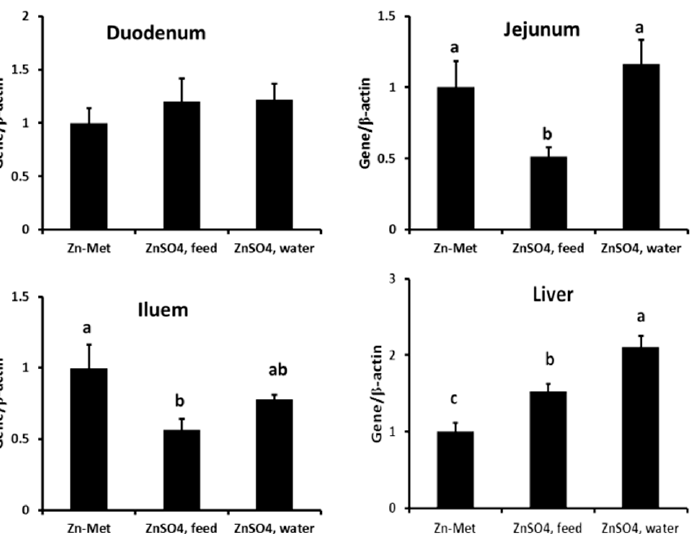
Figure 1. Effect of different Zn supplementation forms on MT mRNA expression in the duodenum, jejunum, ileum, and liver of the piglets. a–c: different letters were significantly different among groups ( p <